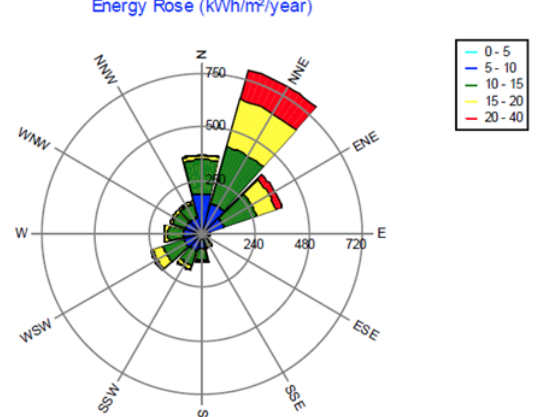
Figure 4. Wind rose diagram at Gori.